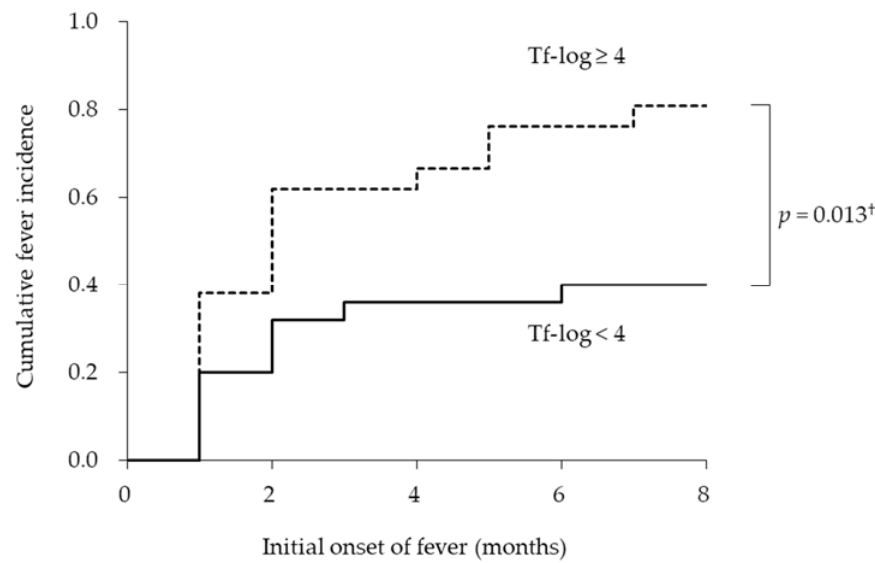
Figure 2. Incidence curves according to logarithmic-conversed bacterial counts of Tannerella forsythia . † log-rank test. Table 4. Cox’s hazard ratio for the onset of fever according to bacterial counts of T. forthysia . Crude